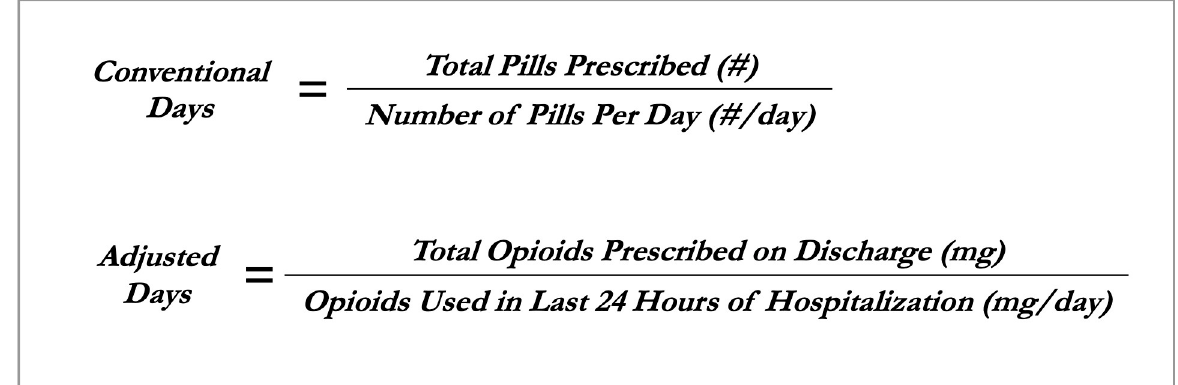
Fig 1. Formulas for calculating opioid prescription duration using the conventional metric and the novel hospital-adjusted metric.